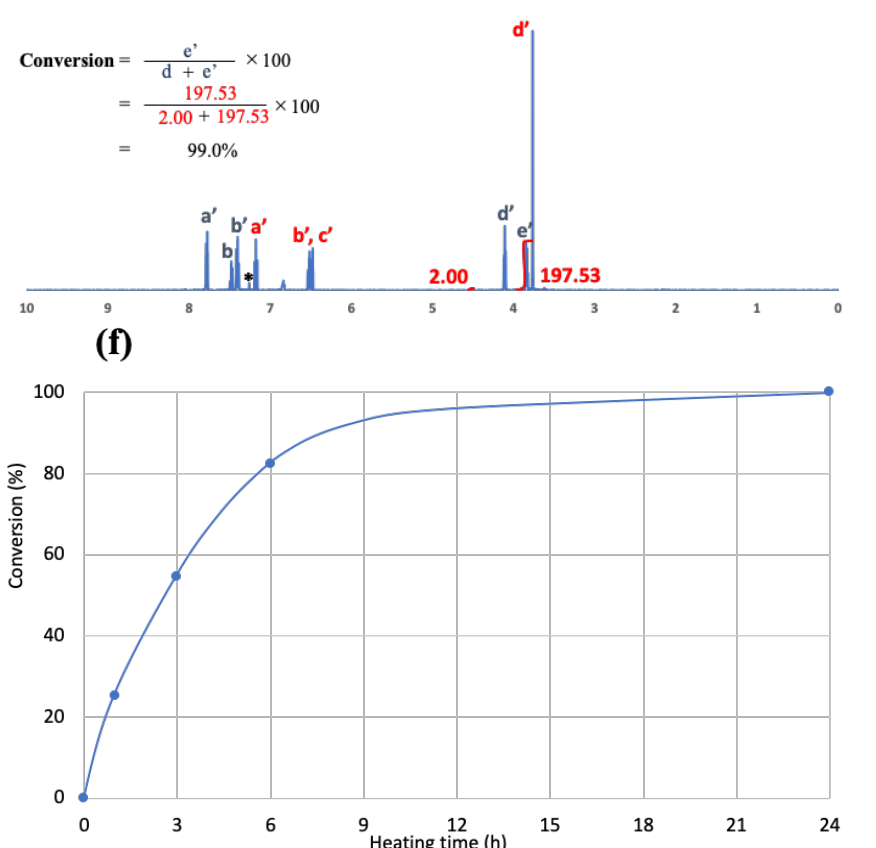
Figure 5. ( a ) 1 H-NMR (500 MHz) spectra for the mixture of 4,5-dihydro-2-phenyloxazoline and 3-methoxyphenol immediately after mixing at room temperature, ( b ) after 1 h at 200 ◦ C, ( c ) after 3 h at 200 ◦ C, ( d ) after 6 h at 200 ◦ C, and ( e ) after 24 h at 200 ◦ C. ( f ) Reaction conversion based on 1 H-